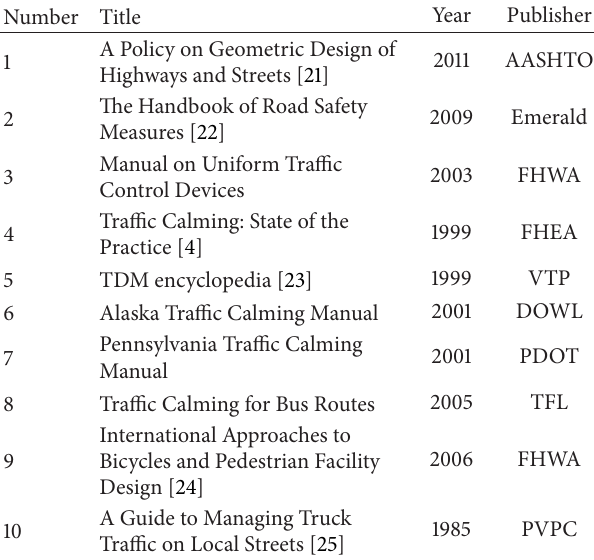
Table 1: List of major sources used in knowledge acquisition.